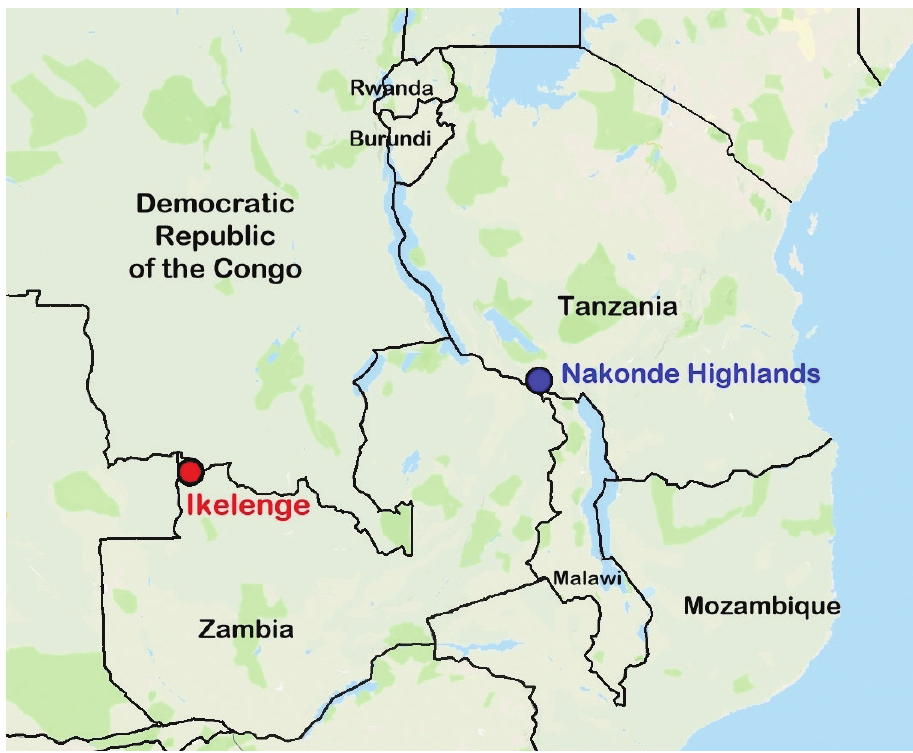
Figure 2. Type localities of Callophylla macrocephala sp. n. (blue circle) and Callophylla takanoi Legrand, 2015 (red circle) in Central – East